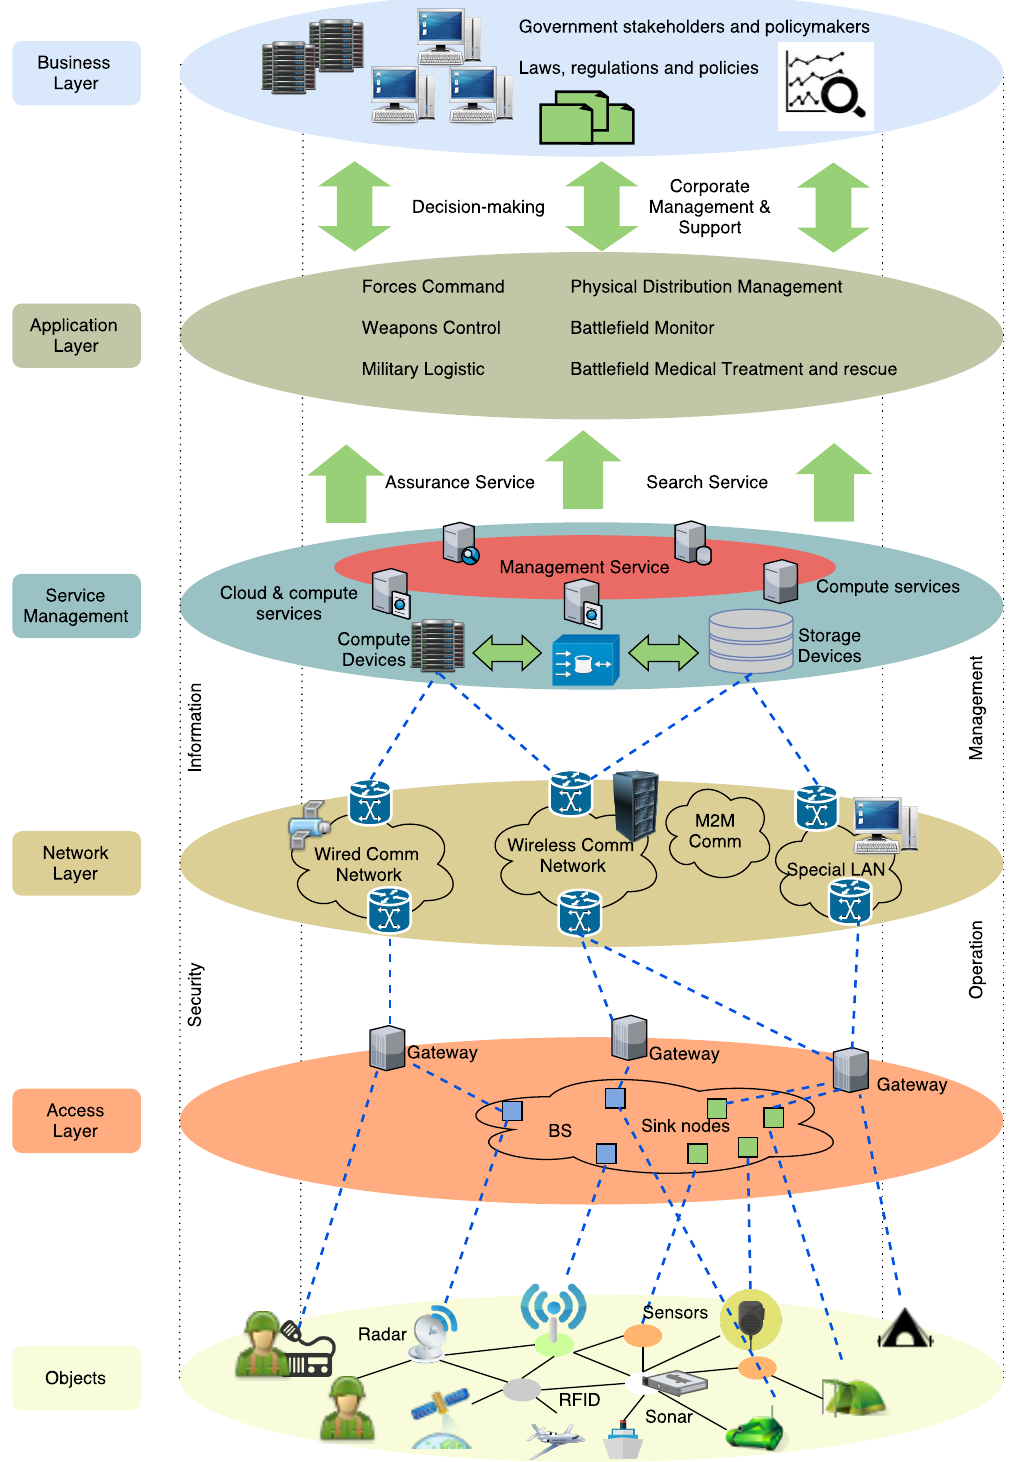
Figure 12. Example of military architecture with six